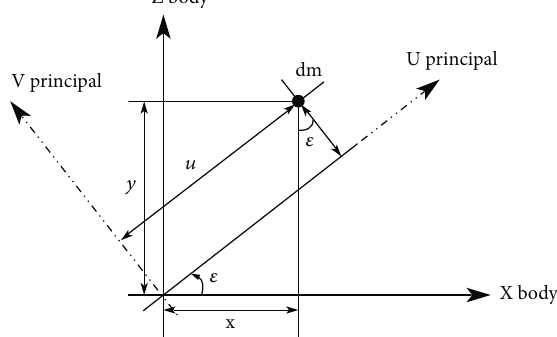
Figure 2: Angle of inclination of the principal